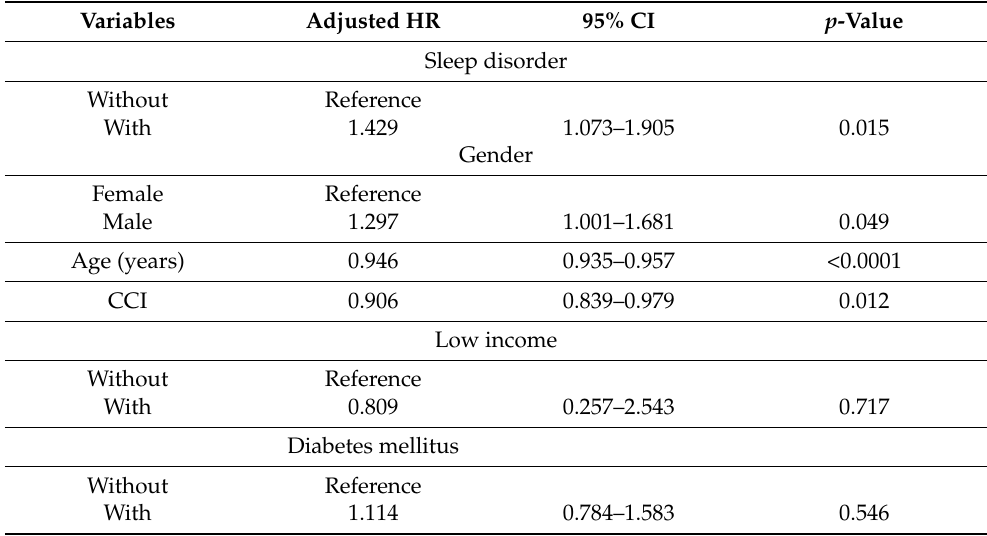
Table 2. Factors relared to suicide at the end of the follow-up, determined using Cox